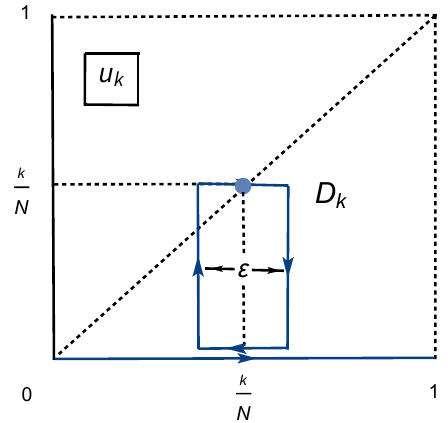
Figure 2 . The new contour of integration that passes through the saddle-point is the sum of the contour along [0 ; 1] and the closed contour D k in each coordinate u k . The (cid:12)gure shows the u k plane for one k with the axes denoting the two components of u k (decomposed in our notation z = z 1 + (cid:28)z 2 ) running from 0 to 1 so as to cover the fundamental